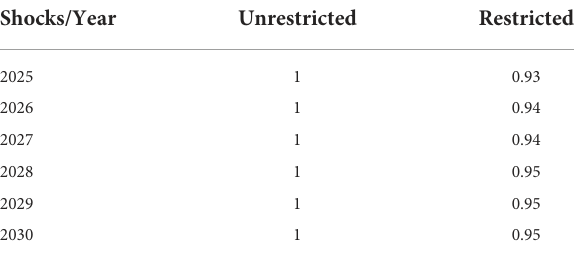
TABLE 4 ASF Recovery scenarios ∧ .